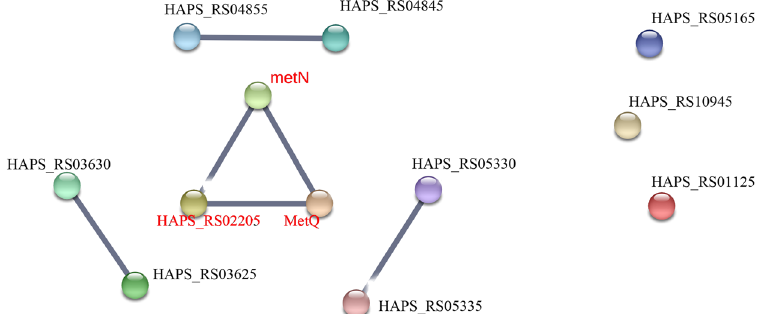
Figure 6. STRING analysis of the relationship between 16 DE genes in ABC transporter. The downregulated genes were marked with red, and the others were upregulated genes.